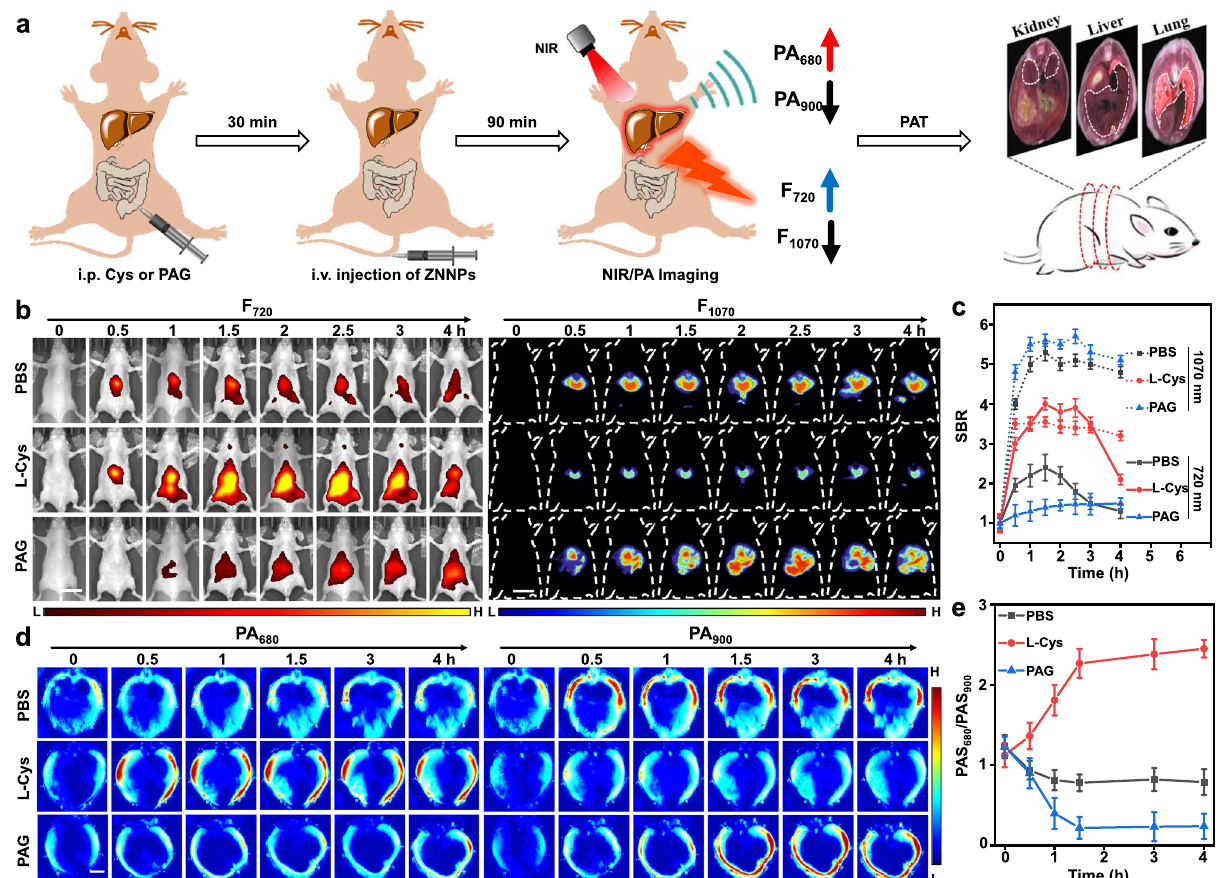
Fig. 4 In vivo fl uorescence and photoacoustic imaging of H 2 S in mouse liver. Balbc-Nu mice were intraperitoneally injected with saline (100 μ L), L-Cys (6 mM, 100 μ L) or PAG (2 mg/mL, 100 μ L) to construct the mice with different levels of H 2 S in livers. a Schematic description for regulation and imaging of hydrogen sul fi de concentration in mouse liver by photoacoustic tomography (PAT). b Fluorescence images and c average fl uorescence intensity at 720 and 1070 nm in region of liver with ZNNPs (10 mg/kg, i.v.) injection ( n = 5). d PA images and e ratio photoacoustic signal (PAS 680 /PAS 900 ) in region of liver treated with ZNNPs (10 mg/kg, i.v.). The scale bars in fl uorescence and PA images were 2 cm and 0.5 cm, respectively. Data are presented as mean ± s.d. ( n = 5). Source data are provided as a Source Data fi